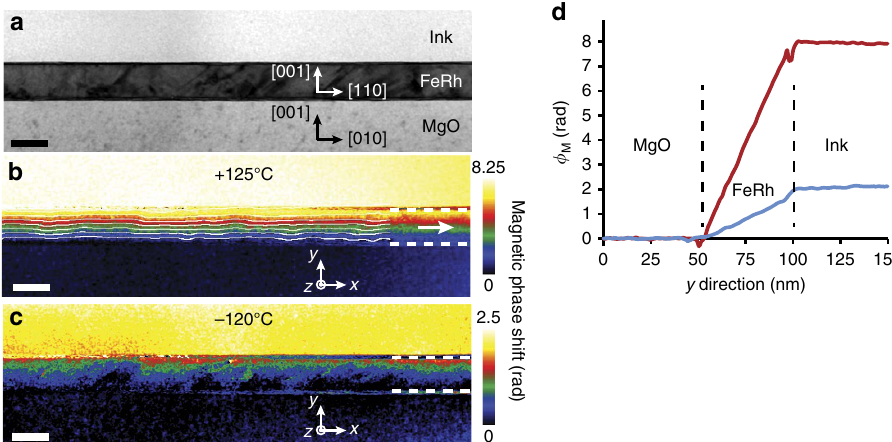
Figure 2 | Electron holography images for the two extreme temperatures. ( a ) Amplitude image of the studied area (630nm (cid:3) 190nm). ( b ) Magnetic phase image obtained at þ 125 (cid:2) C. The FeRh layer is between horizontal dashed lines at the right of the image. The white arrow and isophase lines parallel to the magnetic induction lines into the FeRh layer have been added for clarity. ( c ) Magnetic phase image obtained at (cid:2) 120 (cid:2) C. ( d ) Magnetic phase shift profiles along the y direction averaged over the x direction for the whole field of view. The red and blue curves correspond to the profiles extracted at þ 125 (cid:2) C and (cid:2) 120 (cid:2) C respectively. Scale bars represent 50nm.